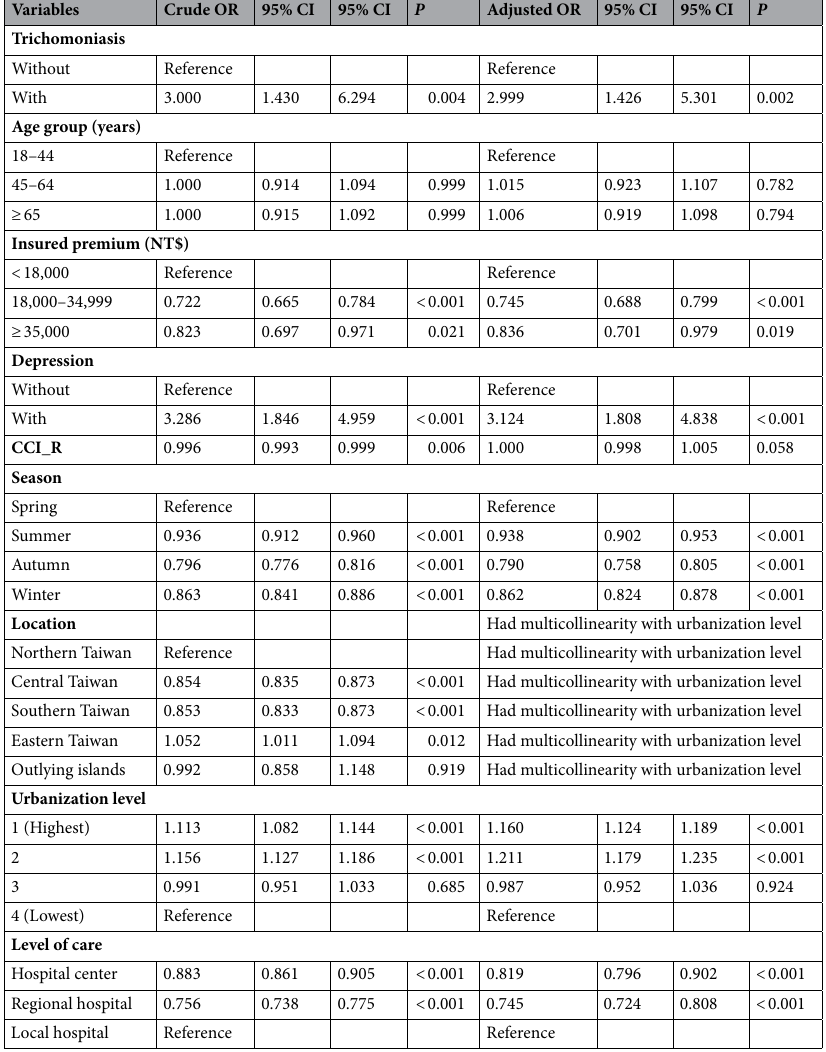
PCa, or BC stratified based on variables using multivariable logistic regression is shown in Table 3. Patients with trichomoniasis had a 2.999 times higher risk of BPH, PCa, or BC than the control group (AOR = 2.999,